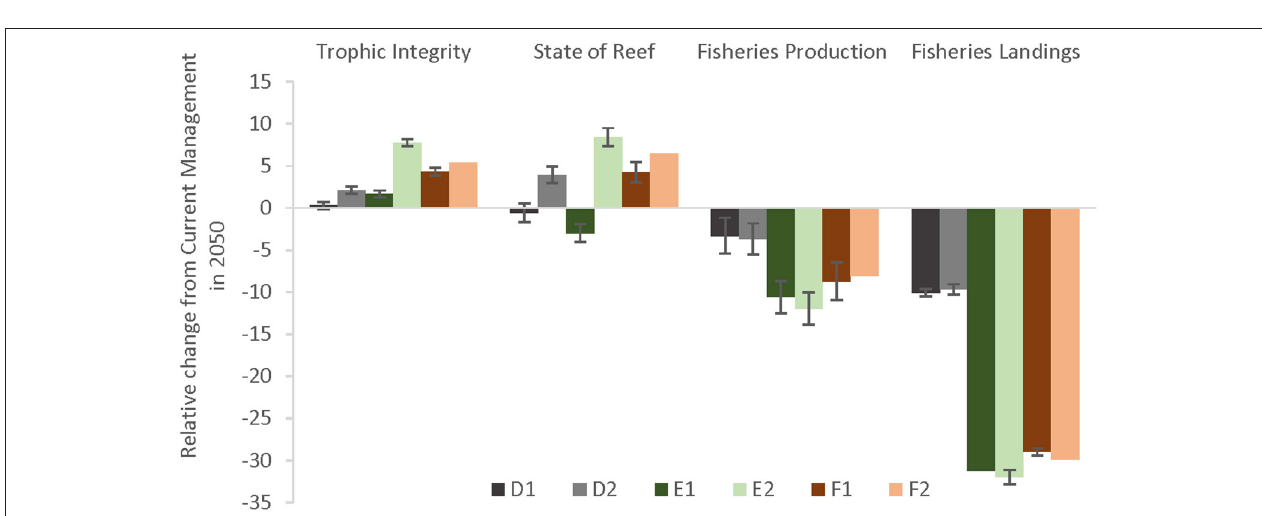
FIGURE 7 | Effectiveness (% change) of additional management compared to Current Management in 2050 under two climate change scenarios. Severe climate-related stressors are represented by darker colors (denoted by a 1 in the scenario letter abbreviations) and less severe stressors in lighter colors (denoted by a 2). The local management scenarios include: (D–gray bars) 10% no-take MPAs and low sediment mitigation, (E–green bars) 30% MPAs and strict sediment mitigation, and (F–red bars) 30% MPAs with an additional 20% reduced piscivore fishing effort and strict sediment